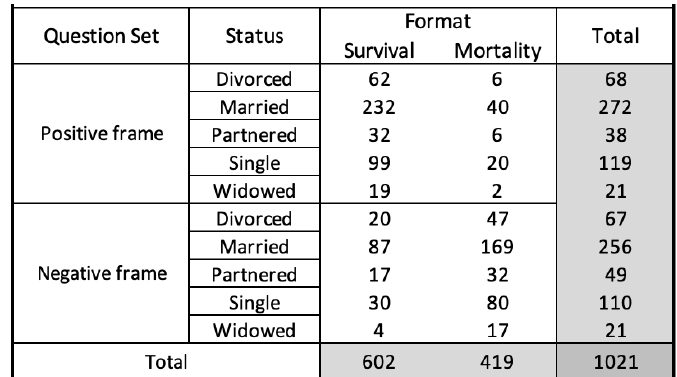
Figure 5. Respondent totals by marital status.